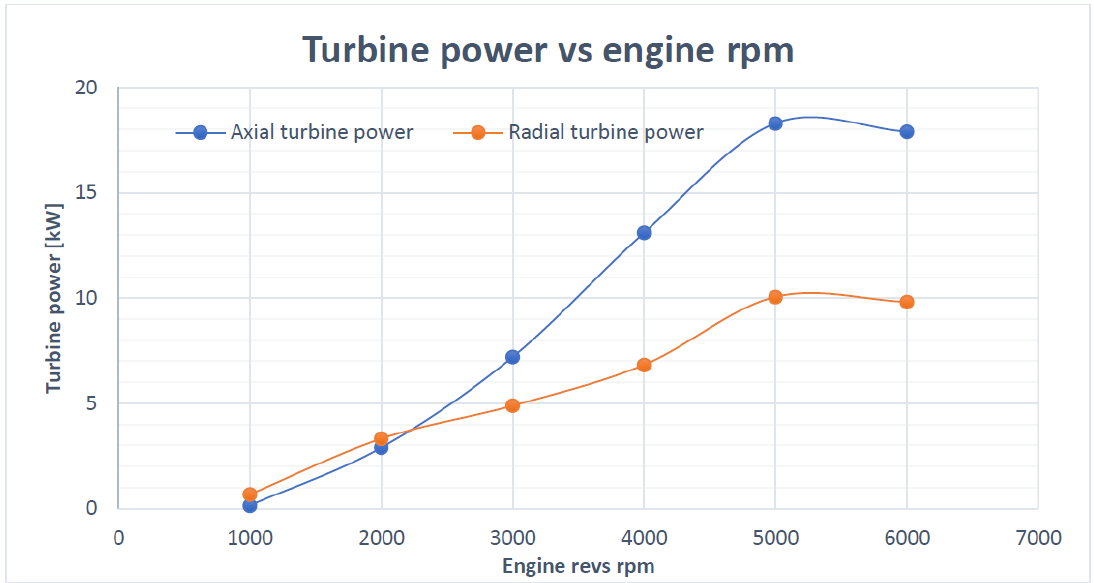
Figure 34. Comparison of generated power for the proposed axial turbine and the OEM radial turbine (3D CFD). Appl. Sci. 2020 , 10 , x FOR PEER REVIEW 32 of 43